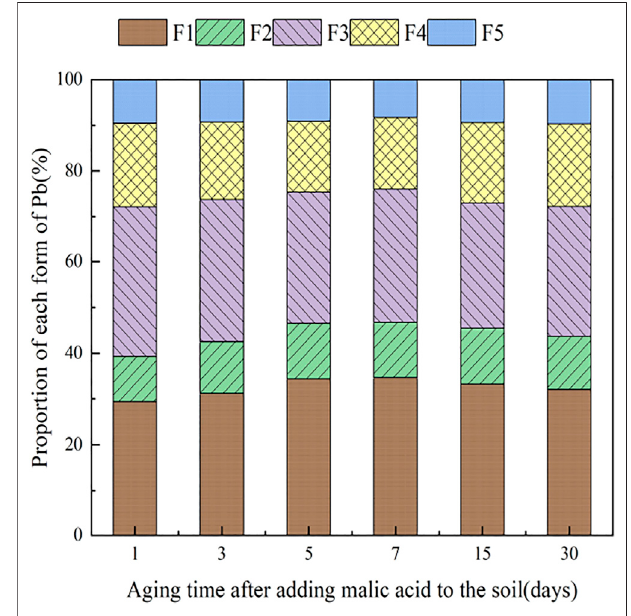
FIGURE 13 | Distribution of Pb in Pb-400 – contaminated soil after adding malic